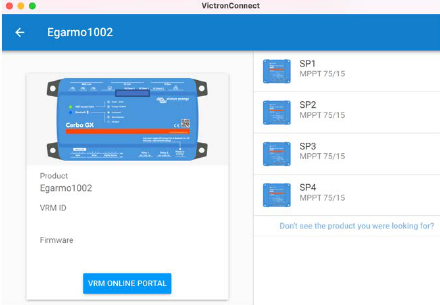
Figure 11. VRN online portal. Figure 11. Victron connect app.